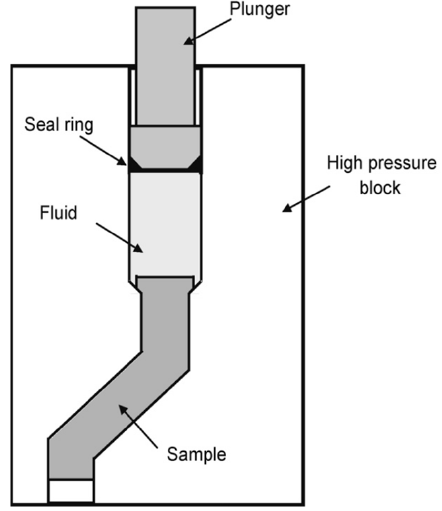
Figure 14. Schematic diagrams of ECAH process.